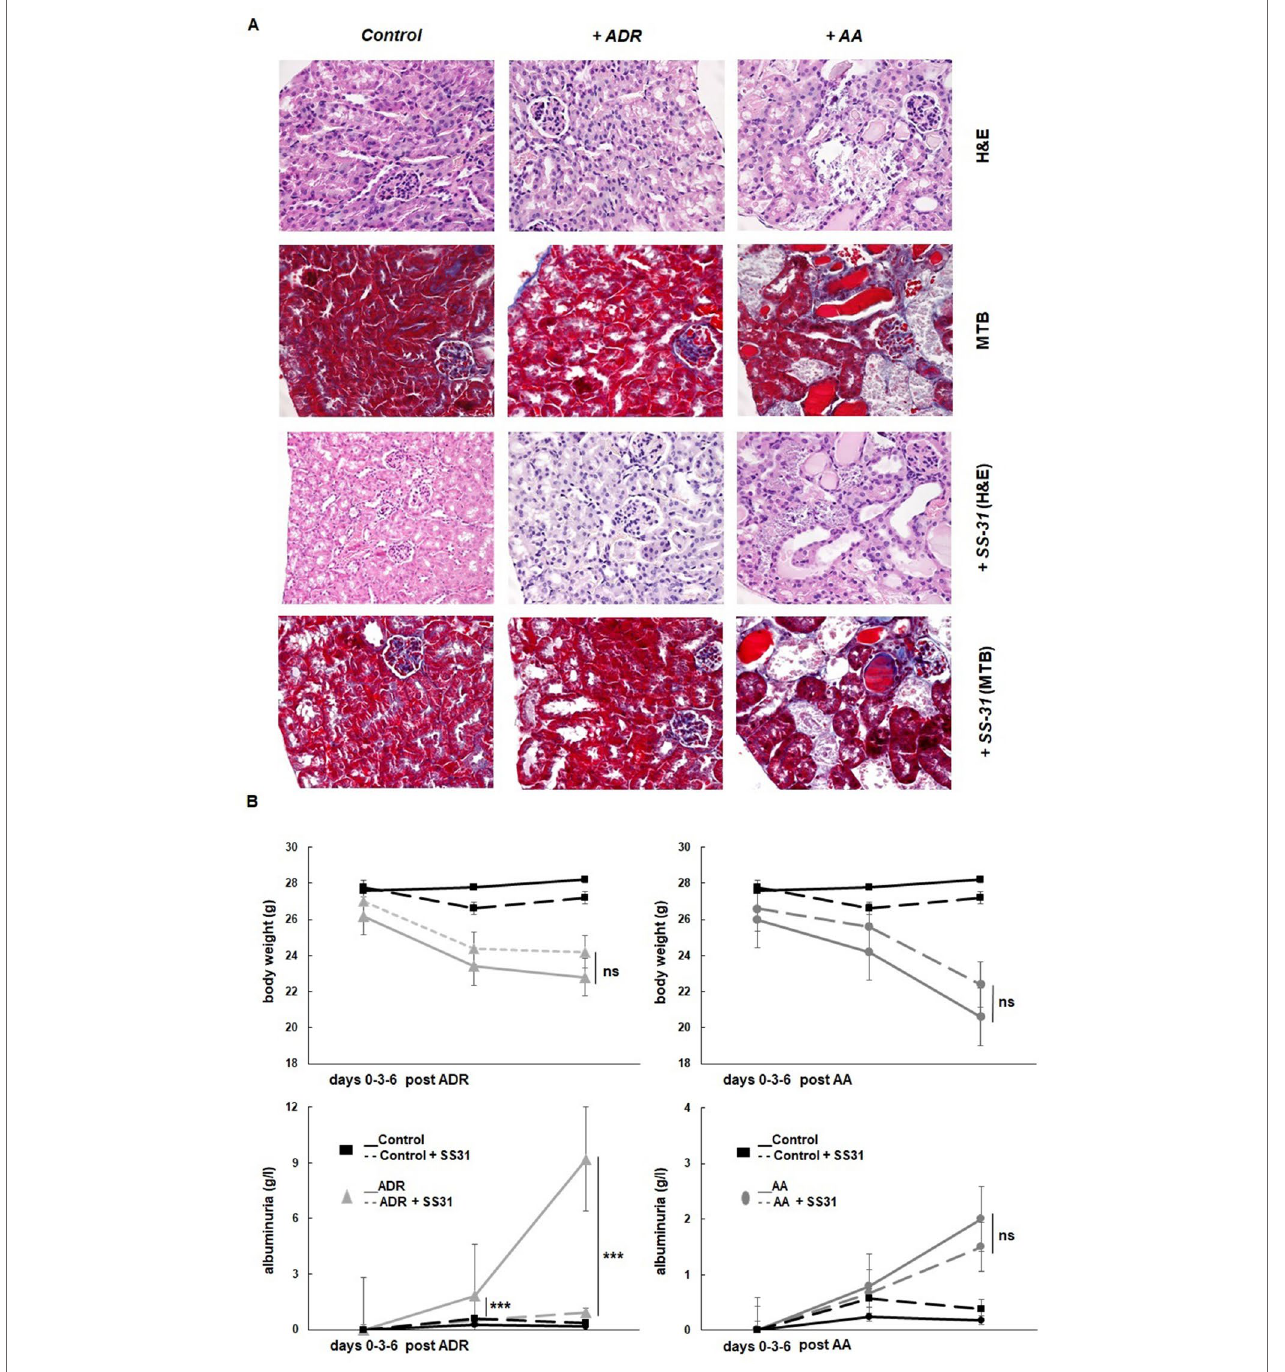
FIGURE 1 | Experimental mouse models of kidney diseases. Kidney injury was induced either by i.p. injection of aristolochic acid (AA, 1x5mg/kg) or adriamycin (ADR, 1x10mg/kg) in 10 weeks old BALB/c male mice (n = 7 animals per experimental group). (A) Hematoxylin/eosin (H&E) or Masson’s trichrome blue (MTB) staining of kidney sections of healthy wild-type control mice and mice treated with ADR or AA, without (above and middle panels) or with SS-31 (lower panels). Representative renal cortical sections per experimental groups are shown (200x magnification). (B) Renal injury was induced by ADR or AA. SS-31 (3 mg/kg) was administered i.p. once a day, starting one day before the disease-inducing drugs (day − 1) and then daily until day 6 (dotted lines) (n = 5 mice per experimental group). The animals were monitored clinically daily, weighted and the level of albuminuria was semi-quantitatively assessed at day 0, day 3 and day 6, and averaged for all animals. Results are presented as means ± sd for all mice in each experimental group, with comparisons between SS-31-treated versus non-SS-31-treated diseased animals (***p <